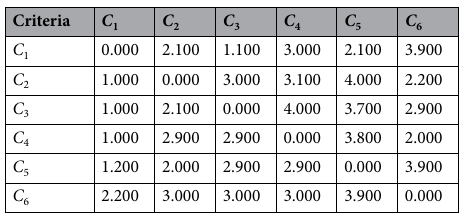
Table 1. The initial influence matrix A